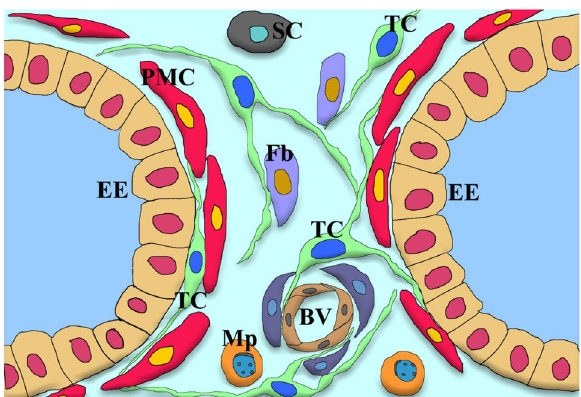
Figure 5. The distribution pattern of TCs in the yak epididymis based on the TCs found in this study. The green image shows that TCs are distributed between the epithelial cells (EE) and peritubular myoid cells (PMC), or between the fibroblasts (Fb) and vascular endothelial cells (VEC), and also attached to stem cells (SC) and macrophages (Mp).